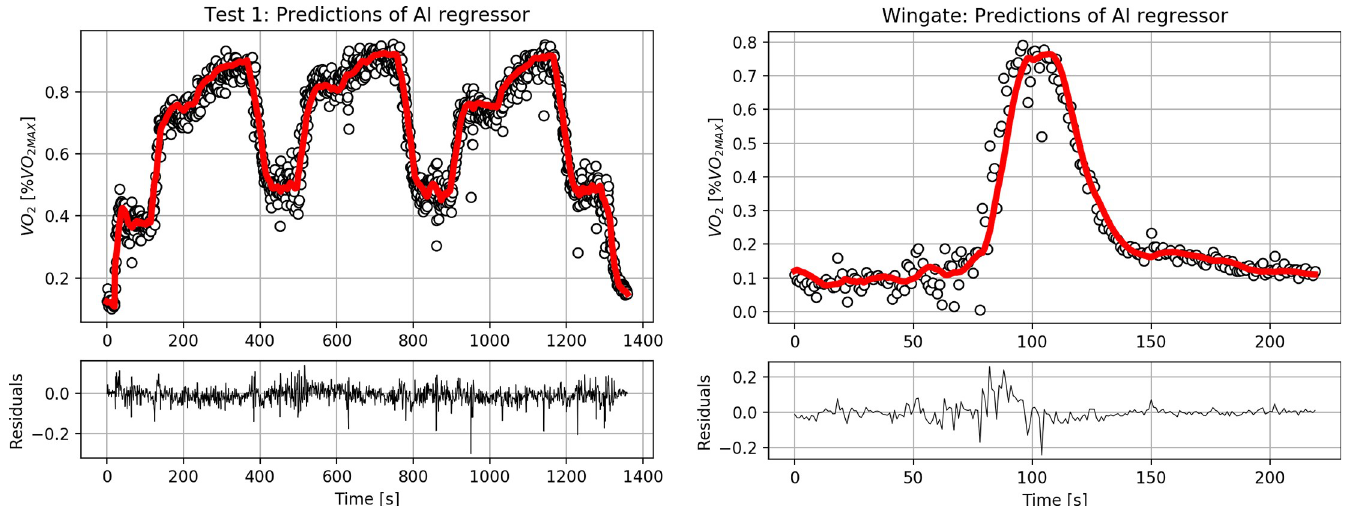
measured versus predicted _ VO showed no proportional error rate, with differences unrelated 2 to the magnitude of the measurement error. In the case of the neural network the bias was not significant. For model 1, the equality line fell outside the confidence intervals of the mean bias of the sample and outside the limits of 200 mlO min -1 . Model 2 performed slightly better than 2 Model 1: the equality line fell outside the confidence intervals of the mean bias of the sample but inside the limits of 200 mlO min -1 . For the neural network, the autocorrelation analysis 2 suggested that there was no significant autocorrelation between observations and lagged obser- vations. In fact, autocorrelation consistently stayed within the confidence bands. In the case of Model 1 and 2, the autocorrelation fell outside the confidence bands for the initial portion of the signal.